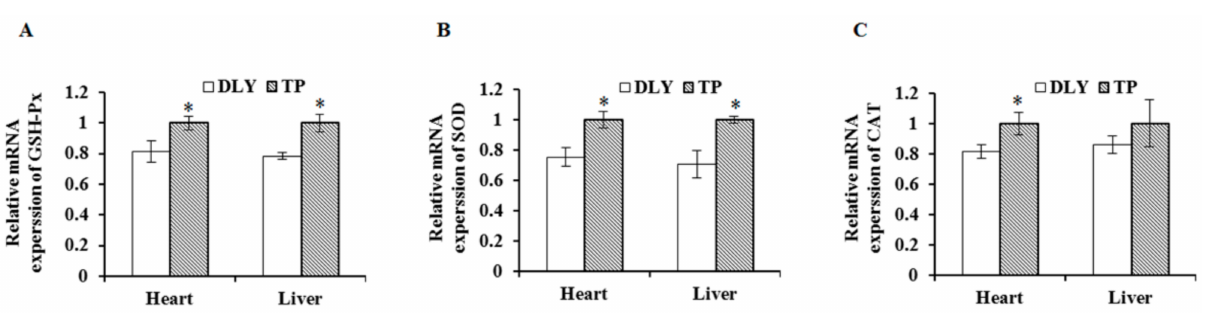
Figure 3. Effects of the plateau environment on mRNA levels of SOD ( A ), GSH-Px ( B ), and CAT ( C ) in heart and liver of TPs and DLY pigs ( n = 12). * Significant difference ( p < 0.05). SOD = superoxide dismutase; GSH-Px = glutathione peroxidase; CAT = catalase.